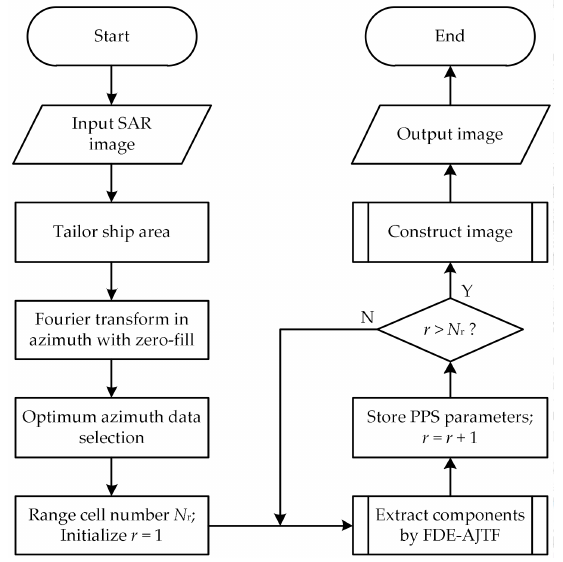
Figure 1. Imaging